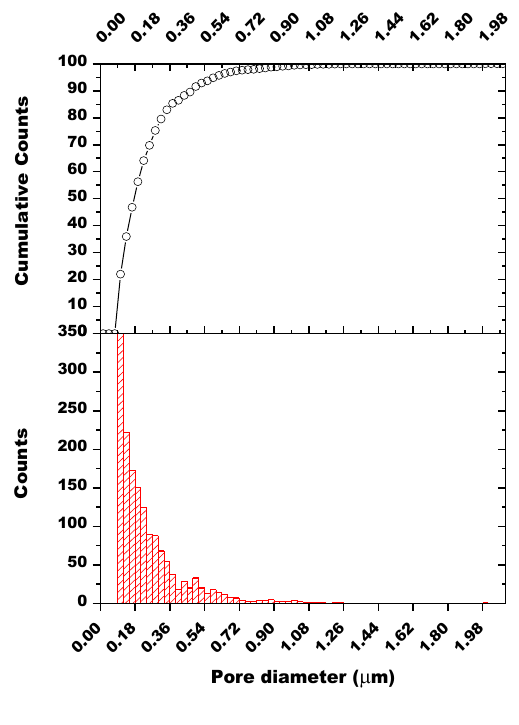
Figure 9. Pore size distribution in the screen printed film (1,593 objects measured).